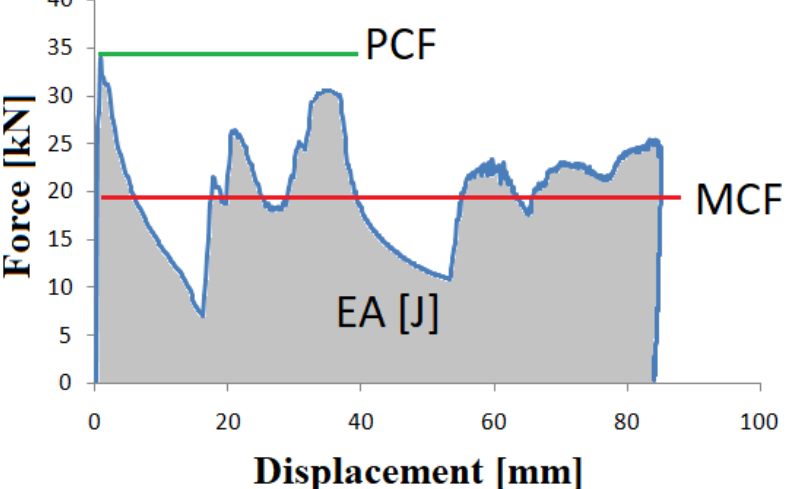
Figure 1. The force-shortening curve for the square energy absorber